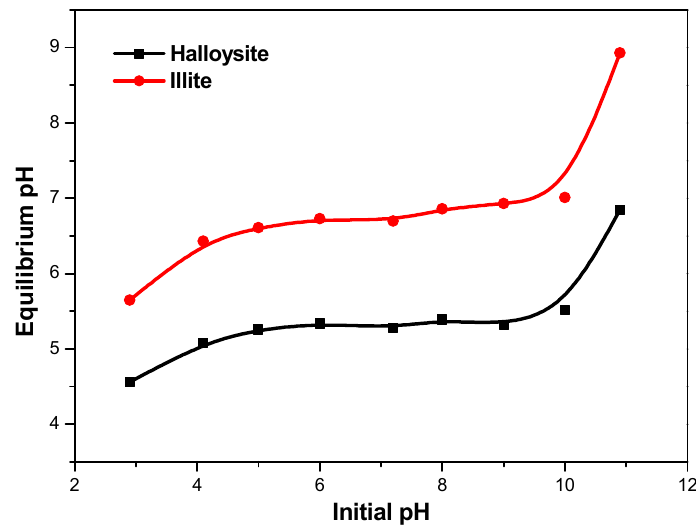
Figure 5. Buffer performance of halloysite and illite at different initial solution pH values.